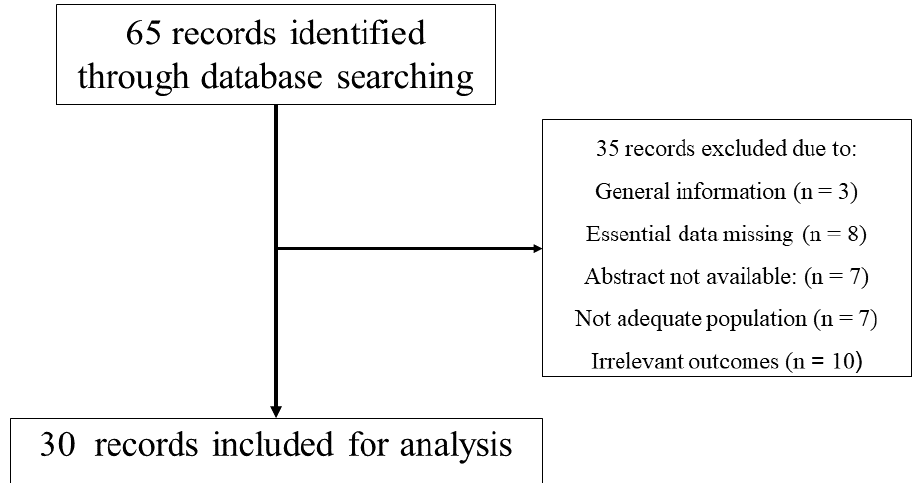
Figure 1. Flow Figure 1. Flow Chart.